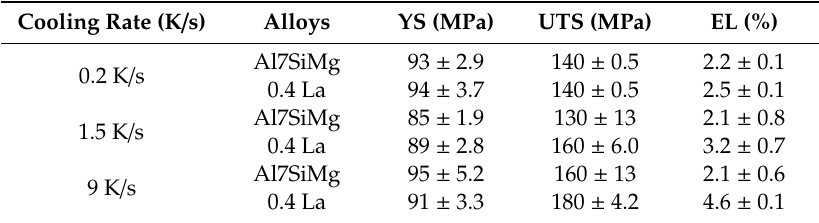
Table 2. Tensile properties of Al7SiMg and Al7SiMg + 0.4La alloys at di ff erent cooling rates. (YS = yield strength, UTS = ultimate tensile strength, EL =